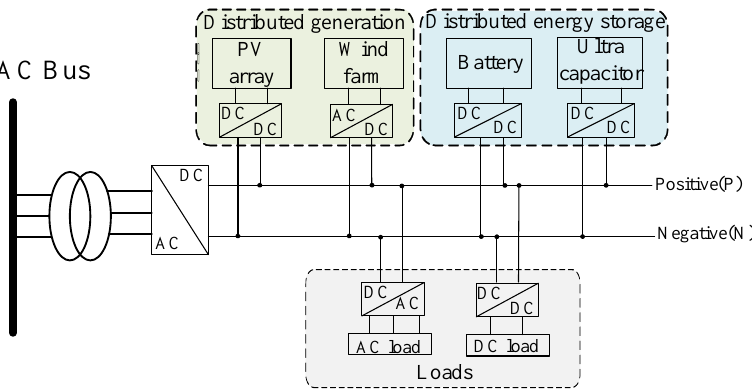
Figure 1. Configuration of a traditional DC distribution network.